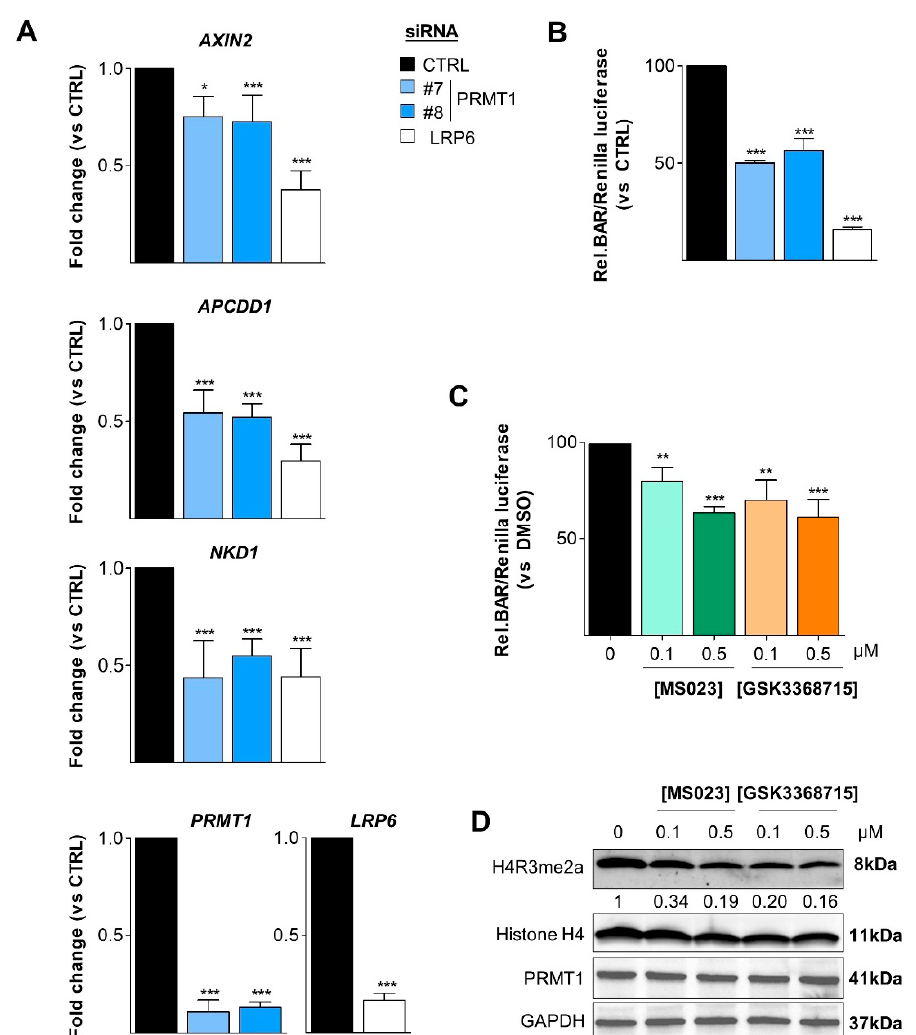
Figure 5. PRMT1 activates the canonical Wnt signaling pathway. ( A , B ) PRMT1 depletion decreases Wnt signaling activity. MDA-MB-468 cells were transfected with control (CTRL, black), two PRMT1 (#7, #8, blue) or LRP6 (white) siRNA for 48 h ( A , B ), and then co-transfected with plasmids coding for BAR-firefly luciferase and Renilla luciferase for 24 h ( B ), before Wnt3a stimulation for 6 h ( A , B ). The expression of AXIN2 , APCDD1 , NKD1 (Wnt target genes), PRMT1 and LRP6 were quantified by qPCR (normalized to actin) ( A ). The relative luciferase signal (firefly luciferase/Renilla luciferase) is represented as a percentage normalized to the control siRNA (CTRL) ( B ). siRNA targeting LRP6 was used as a positive control ( A , B ). ( C ) Type I PRMT inhibitors decrease Wnt signaling activity. MDA-MB-468 cells were treated with 0.1 µ M or 0.5 µ M of MS023 (green) or GSK3368715 (orange) for 48 h, and then co-transfected with plasmids coding for BAR-firefly luciferase and Renilla luciferase for 24 h, before Wnt3a stimulation for 6 h. The relative luciferase signal (firefly luciferase/Renilla luciferase) is represented as a percentage normalized to the DMSO-treated cells (black). ( D ) PRMT1 inhibition was verified in this experiment ( C ) by Western blotting using anti-H4R3me2a antibody. Anti-histone H4, PRMT1, and GAPDH were used as loading controls. Intensity ratio of methylated histone H4 is indicated as a fold change relative to DMSO, after normalization to the loading control ( D ). All quantifications are represented as a fold change ( A ) or percentage ( B , C ) relative to the control. The data are expressed as the mean ± SD from at least three independent experiments ( A – C ). p -values from Student t -test are represented as * p < 0.05; ** p < 0.01; *** p <